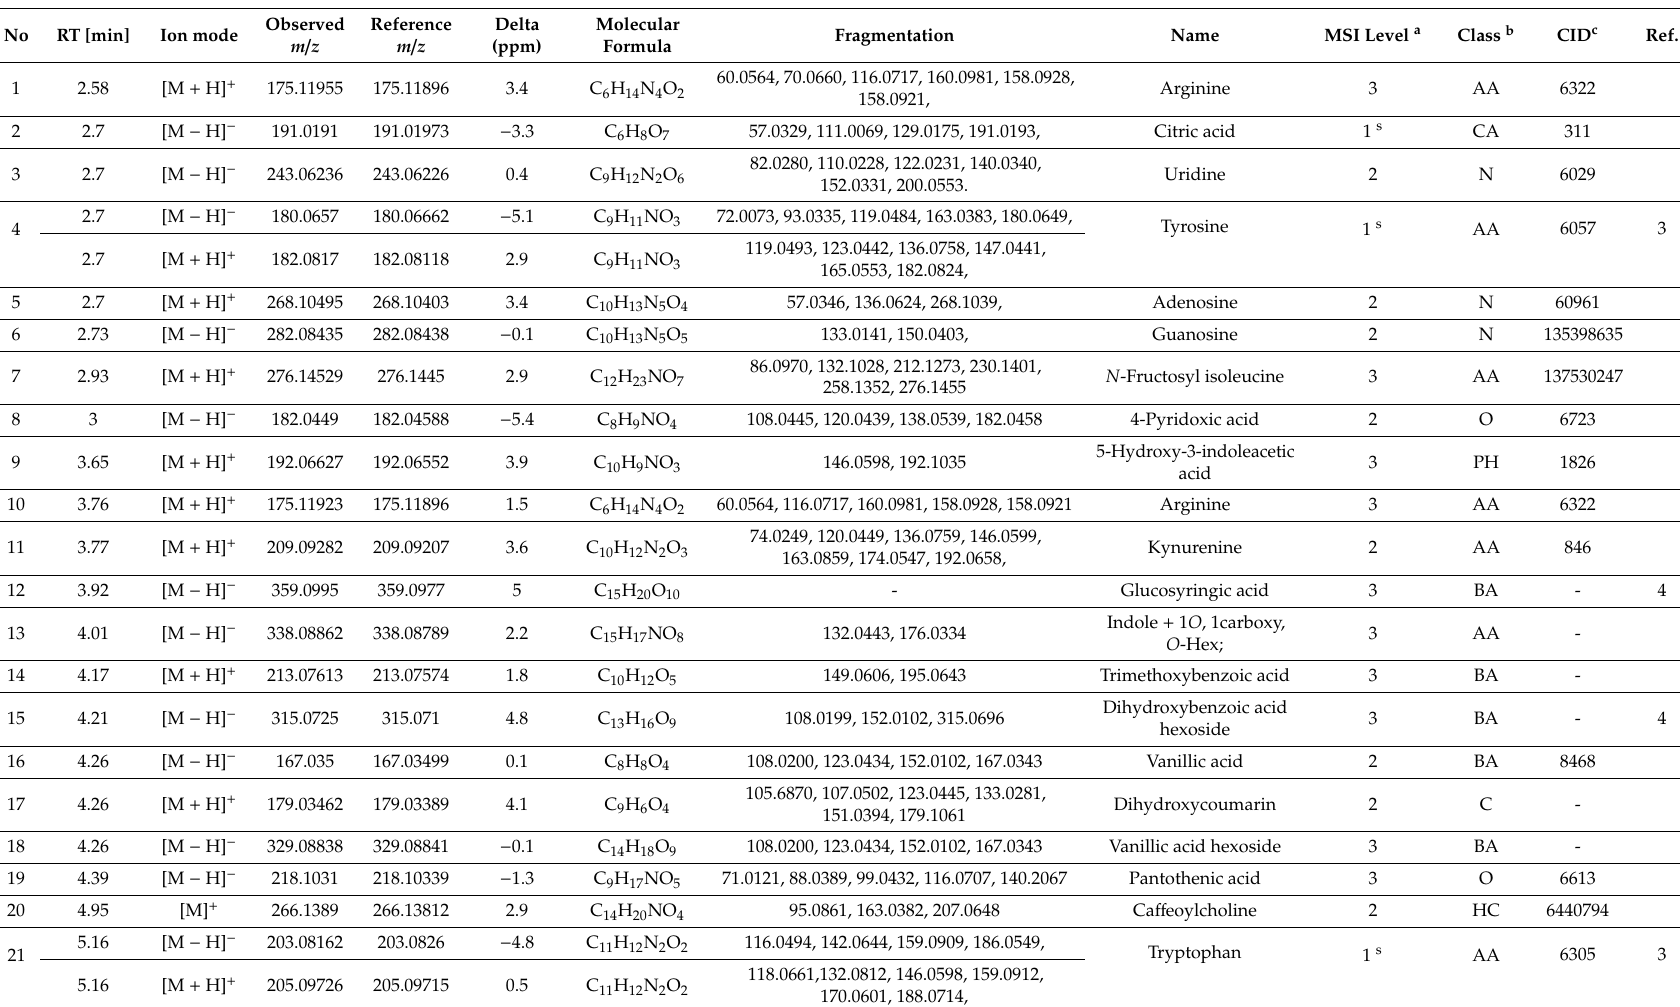
Table 2. The annotated compounds in the shoot extracts of Eryngium alpinum L. from in vitro culture and in vivo plant. Metabolites detected by UPLC-HESI-II-HRMS. The compounds were characterized by the exact mass and the fragmentation pattern in negative and positive ion